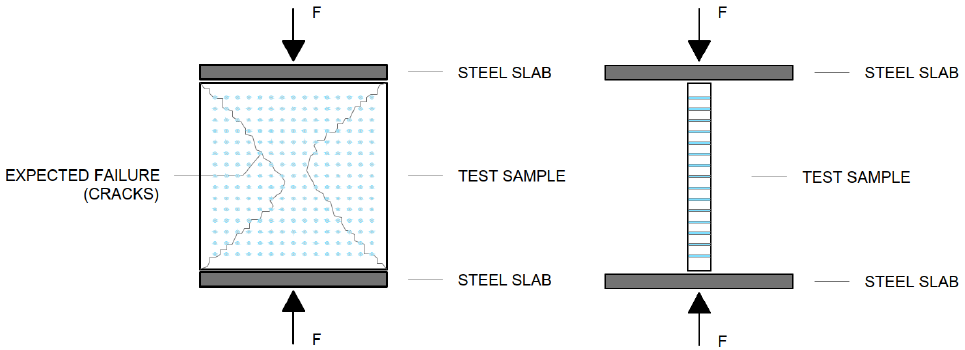
Figure 35. Compressive strength test diagram for LTC slabs.